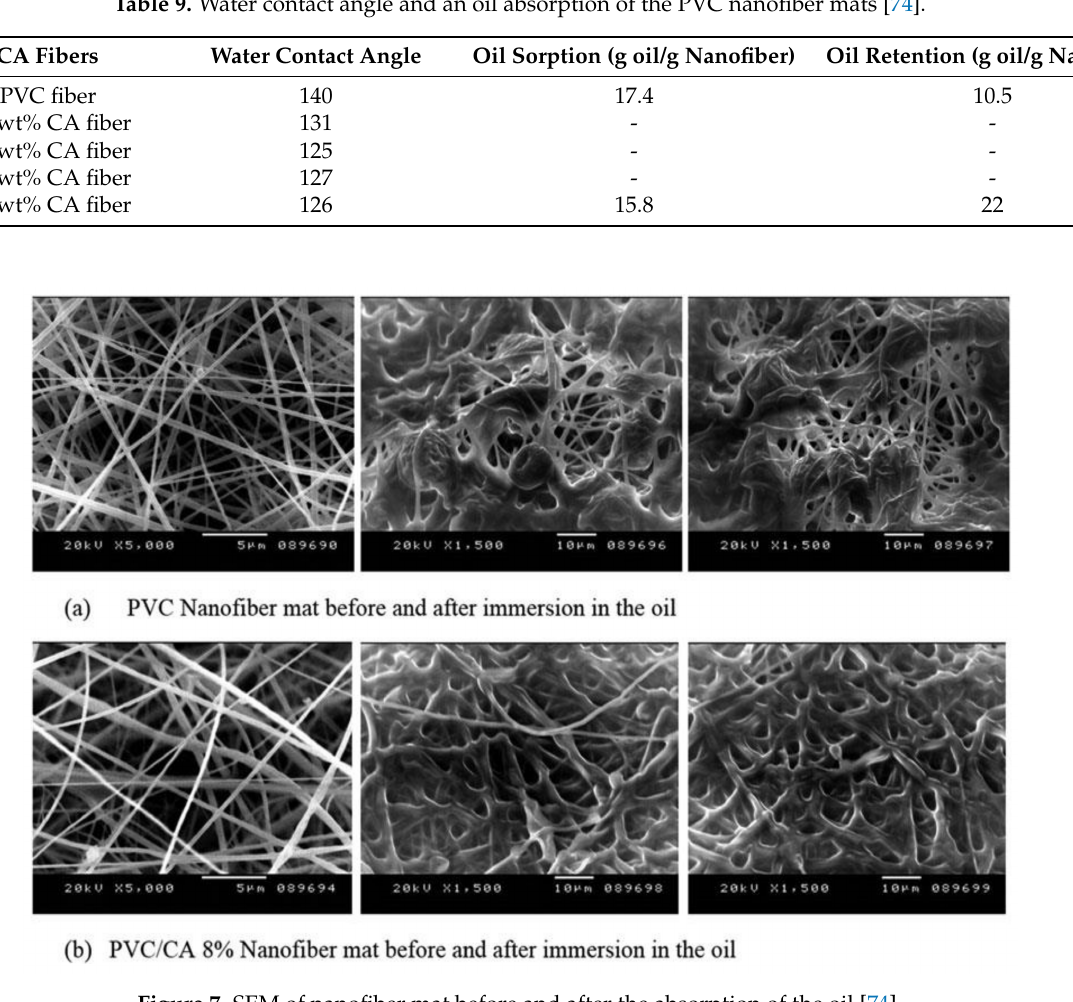
Figure 7. SEM of nanofiber mat before and after the absorption of the oil